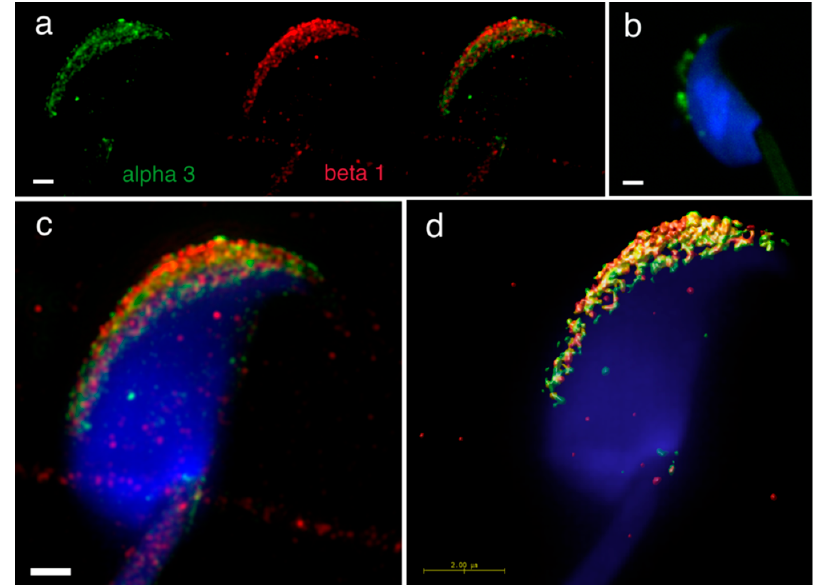
Int. J. Mol. Sci. 2018 , 19 , x sperm head, ( b ) PLA confirmed a presence of the α 3 β 1 heterodimer. ( c ) SIM depicted their mutual localization in same structures. ( d ) Huygens software was used for better visualization of colocalization area (yellow) of α 3 and β 1. Colocalization maps are based on Pearson’s correlation